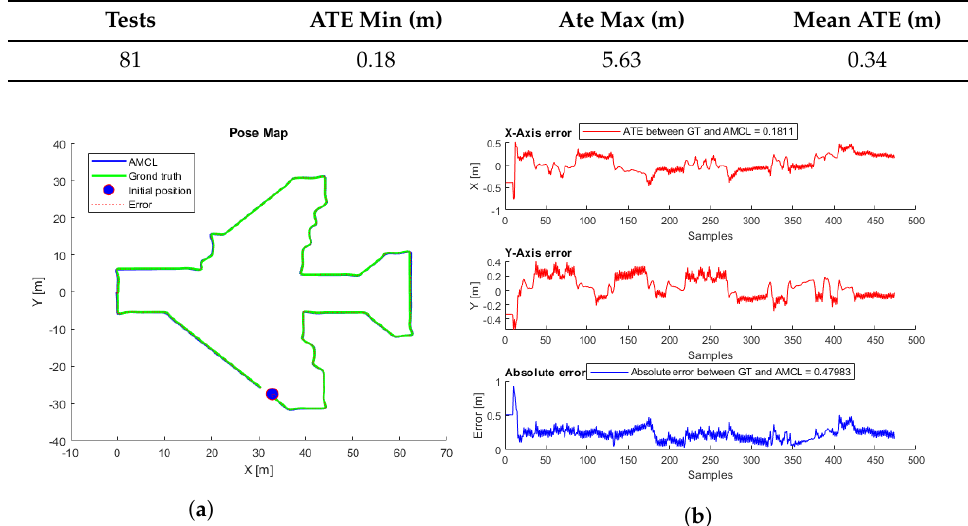
Figure 9. ( a ) AMCL simulation test with the lowest ATE. AMCL (blue), ground-truth (green), take-off position (blue circle), error (red). ( b ) AMCL